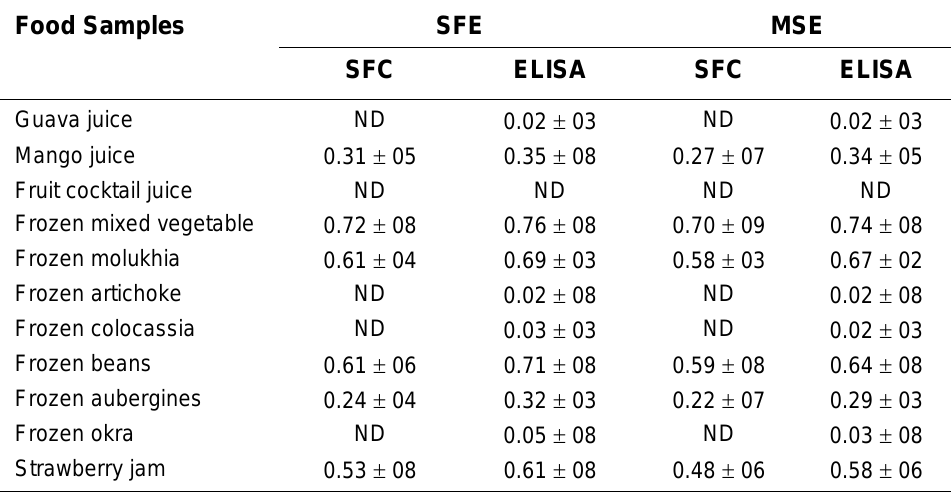
Atrazine Residues (PPb) and RSD in Food Samples Extracted by SFE and MSE, Determined by SFC at 220 nm and ELISA Technique at 450 nm SFE MSE Food Samples SFC